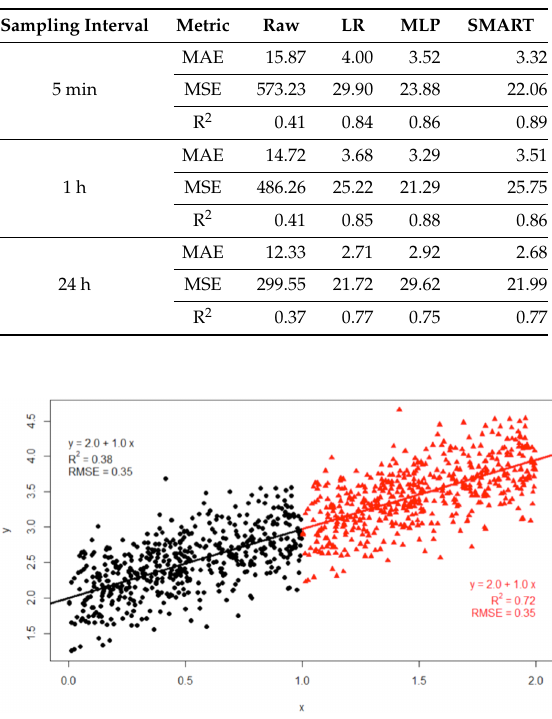
Figure 10. A characteristic of R 2 according to widen data range. The black dot alone has R 2 = 0.38, while the black dot and red triangle have R 2 = 0.72. However, their regression line and RMSE are the same (Figure quoted [35]). This descriptive statistic is also required when R 2 is used as a